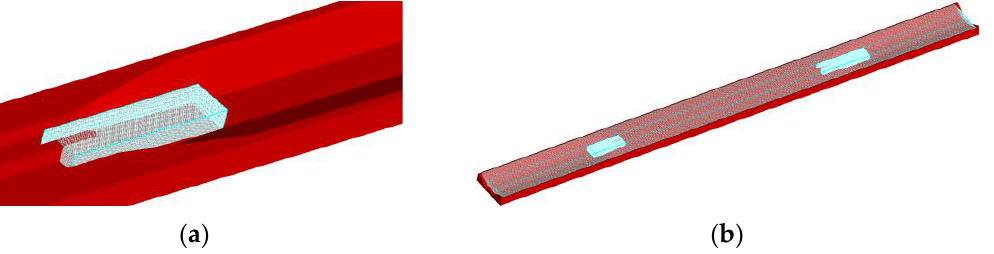
Figure 3. Grid division. ( a ) Export gradient segment local encryption; ( b ) Model meshing.